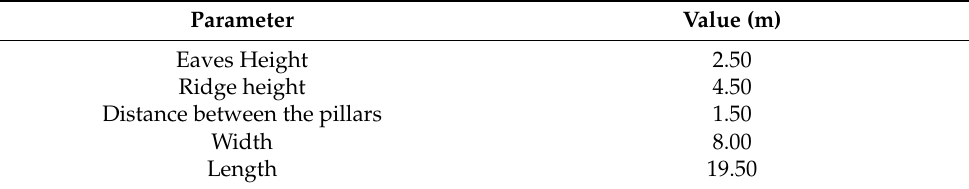
Figure 1. Greenhouse structure built for the composting tests. Table 1. Dimensional parameters of the greenhouse.